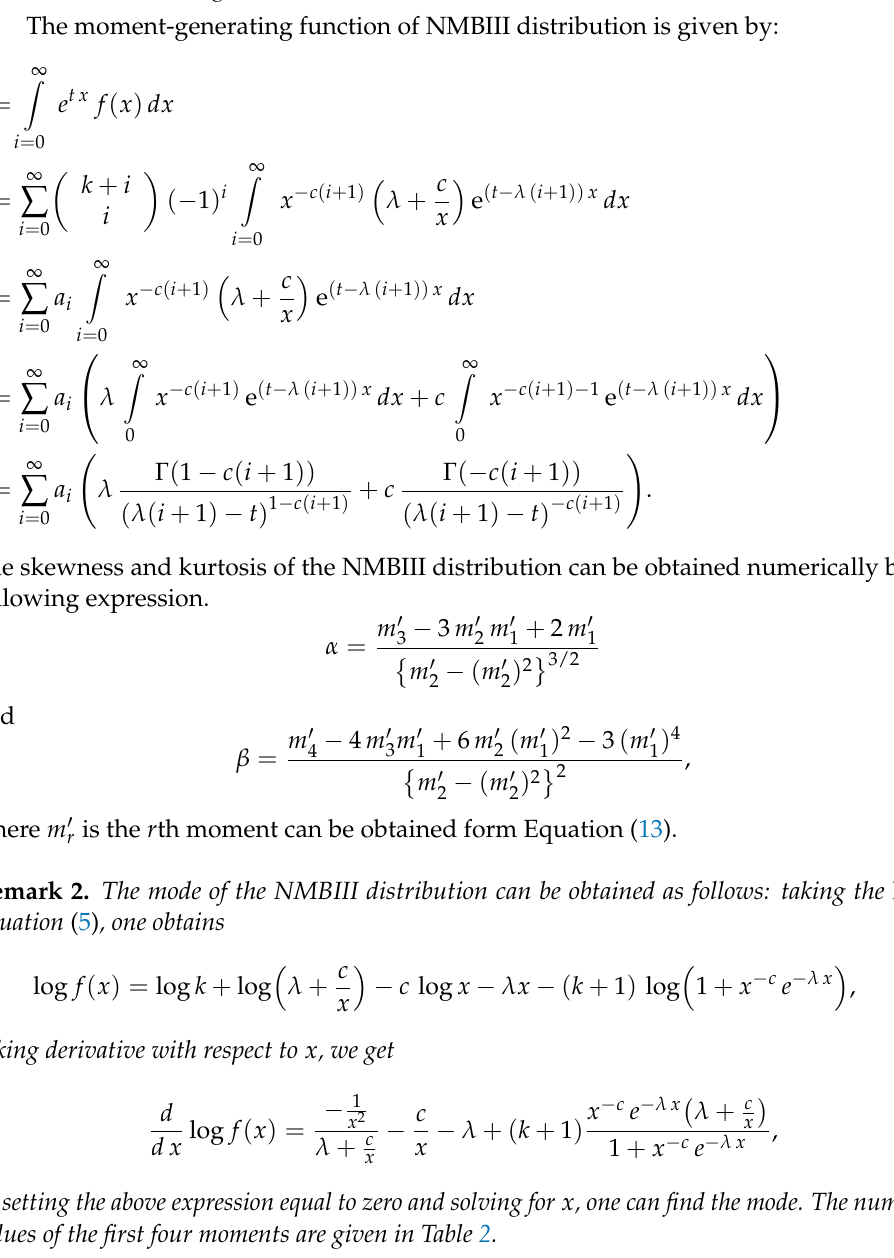
Table 2. The numerical values of the first four moments ( m (cid:48) r , r = 1,2,3,4 ) , skewness ( α ) and kurtosis ( β ) of the NMBIII for some parameter